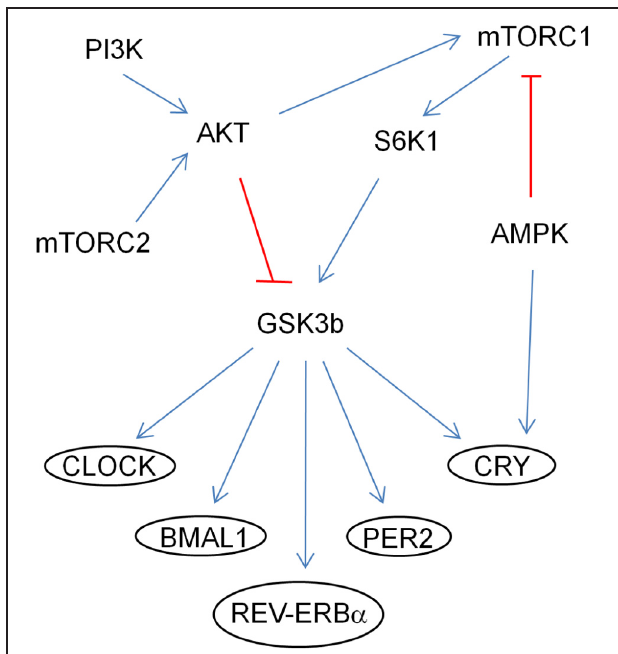
FIGURE 2 | Regulation of CLOCK proteins by the mTOR pathway through GSK3 β . The arrows (in blue) indicate activation of the targets and the ones (in red) indicate inhibition by